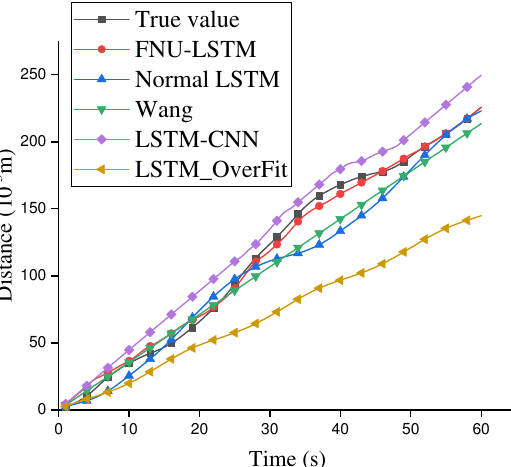
Figure 13. Scatter plot of predicted distance error of each fire spreading model.